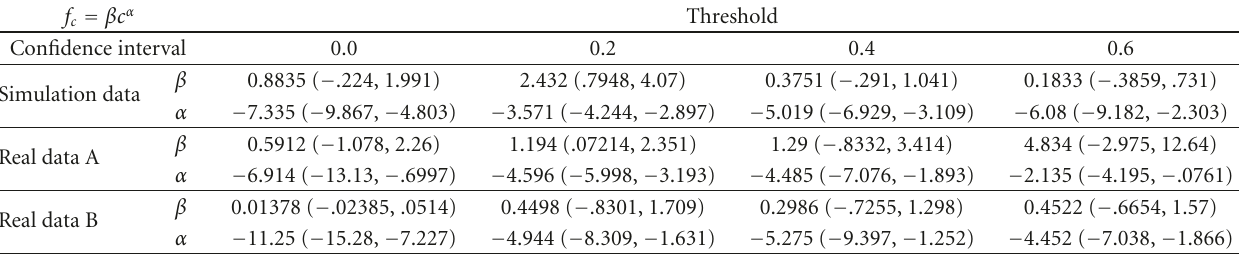
Table 2: Confidence intervals for parameters of power law distribution of clustering coe ffi cients (confidence level = 95%). f c = βc α Threshold Confidence interval